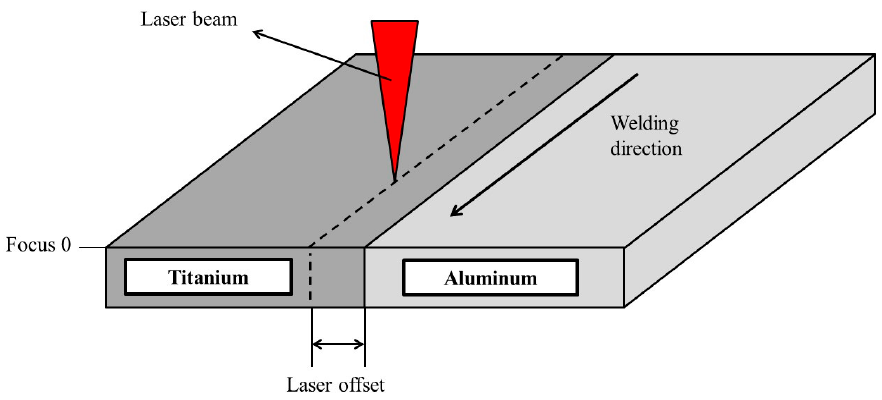
Figure 2. Offset and focus positions.